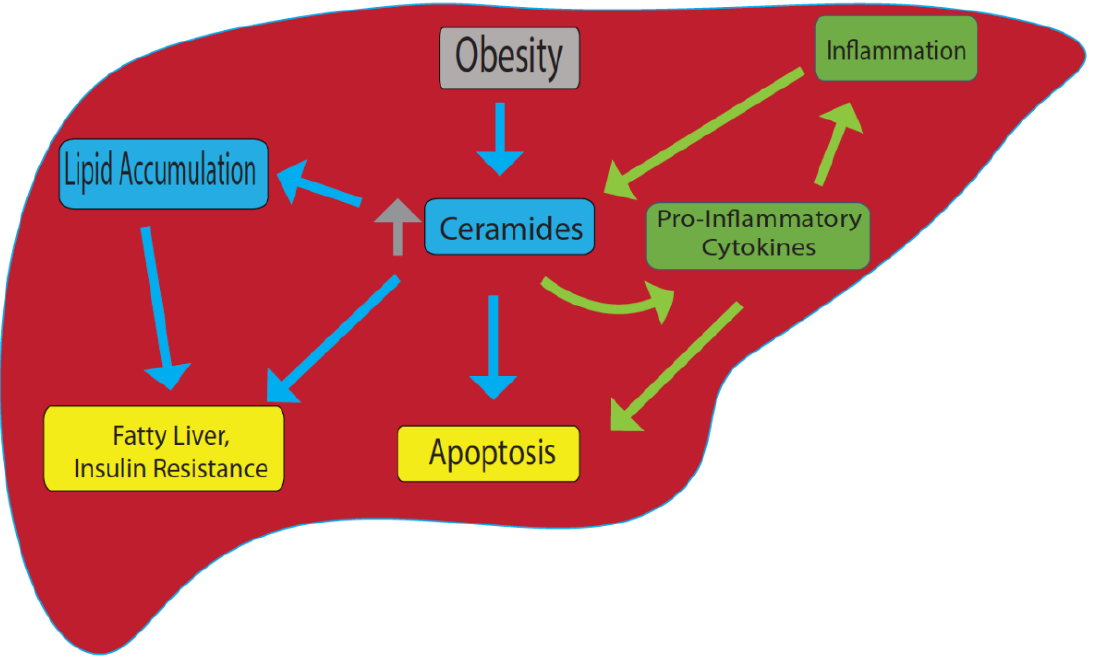
Figure 1. Model for ceramide-induced fatty liver and other metabolic disorders . In obesity, ceramide levels are upregulated, and this leads to accumulation of lipids, fatty liver and insulin resistance. On the other hand, inflammation can cause an increase in ceramide levels that promotes pro-inflammatory cytokine production. Increase in ceramide also cause apoptosis. Yellow: end results; Blue: linked specifically to obesity; green: linked specifically to inflammation.